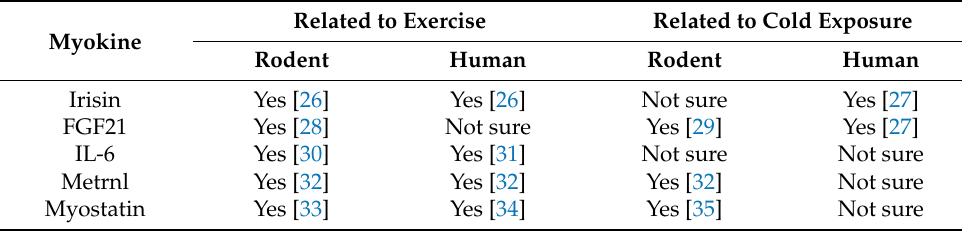
Table 1. Myokine changes in response to exercise and cold